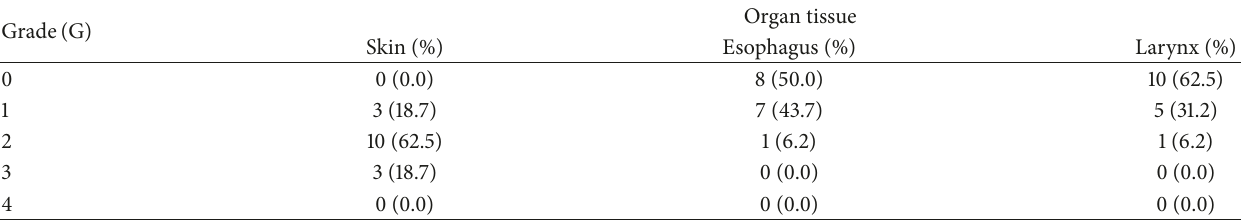
Table 4: Acute toxicity after radiation treatment (maximum recorded grade).